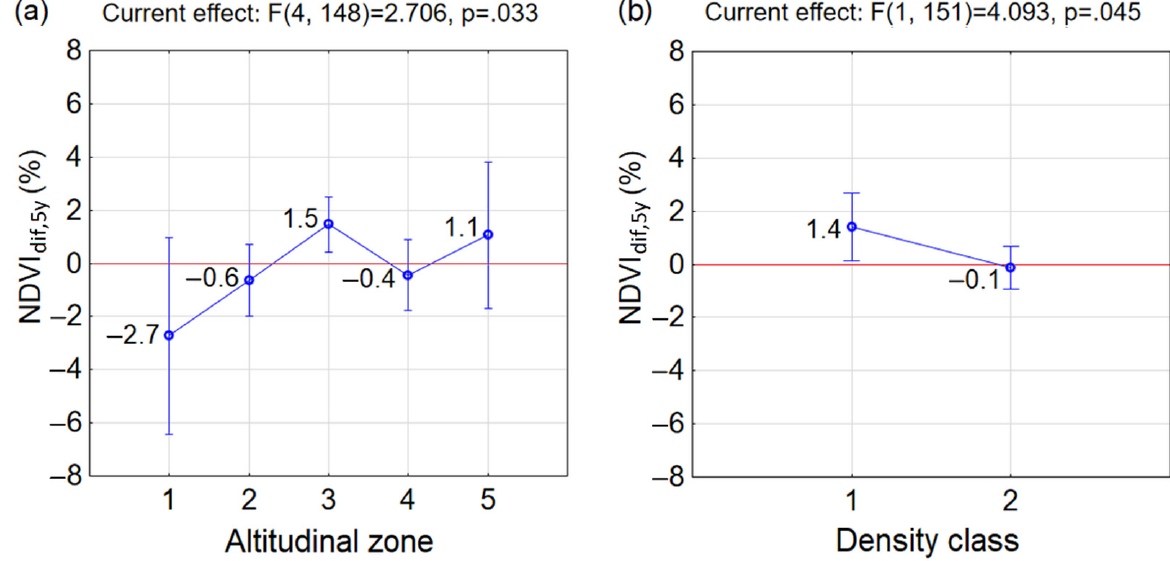
Figure 7. Change of vegetation greenness in P. mugo thickets between 2020 and 2000 ( a ) in each altitudinal zone and ( b ) in density classes. The blue circle marks the group mean and the vertical bars denote the 0.95 confidence intervals. The positive values indicate the increase of NDVI in 2020 compared to 2000, and vice versa.